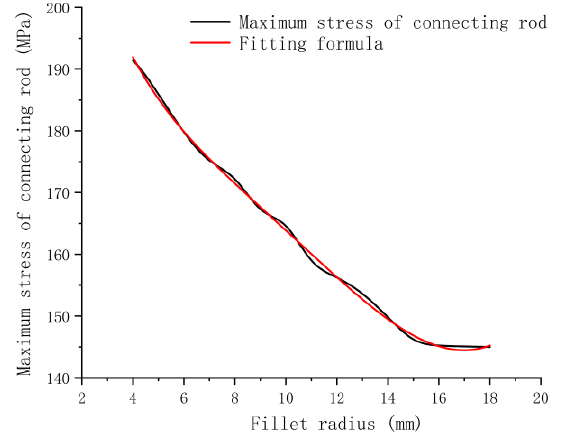
Figure 21. Comparison between the curve of influence of fillet radius on maximum stress of connecting rod and the formula curve after iteration.